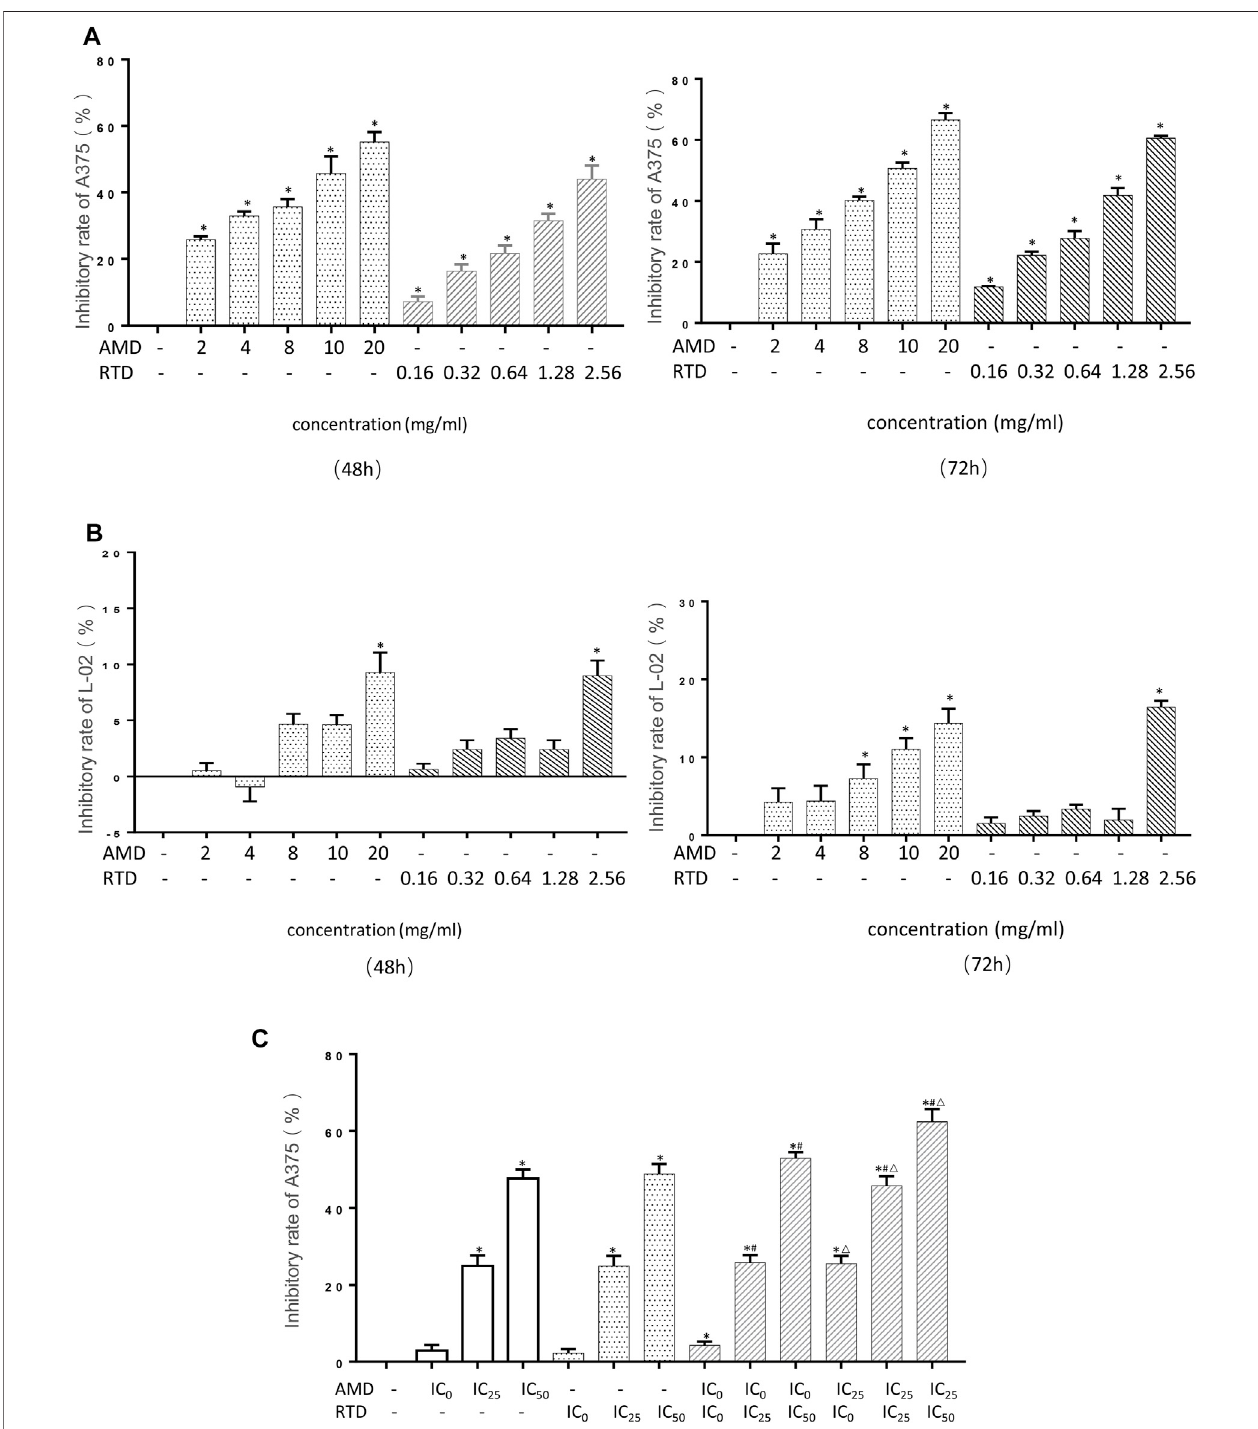
FIGURE3| AMD, RTD,and theircompatibility inhibited cellproliferation. (A – B) Effect ontheA375cells (A) andL-02 (B) cellproliferation indifferentconcentrations ofAMDandRTDfor48and72 h. (C) EffectofAMD,RTD,andtheircompatibilityontheA375cellproliferationfor48 h. n =5. p p < 0.05,comparedwiththecontrolgroup. # p < 0.05, compared with the corresponding AMD group. △ p < 0.05, compared with the corresponding RTD group.